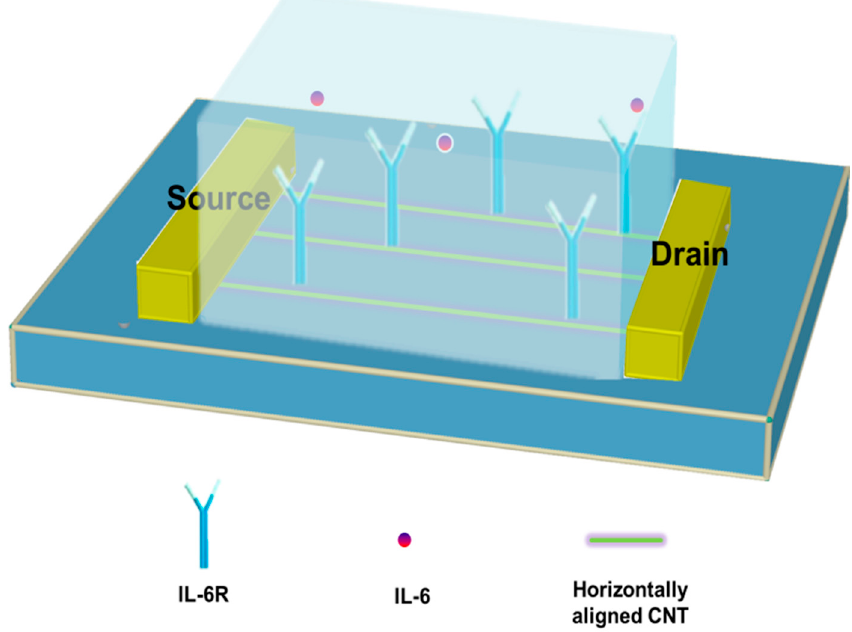
Figure 1. Schematic illustration of liquid-gated field effect transistor (FET) sensors based on horizontally aligned carbon nanotubes for detection of prostate-specific antigen.